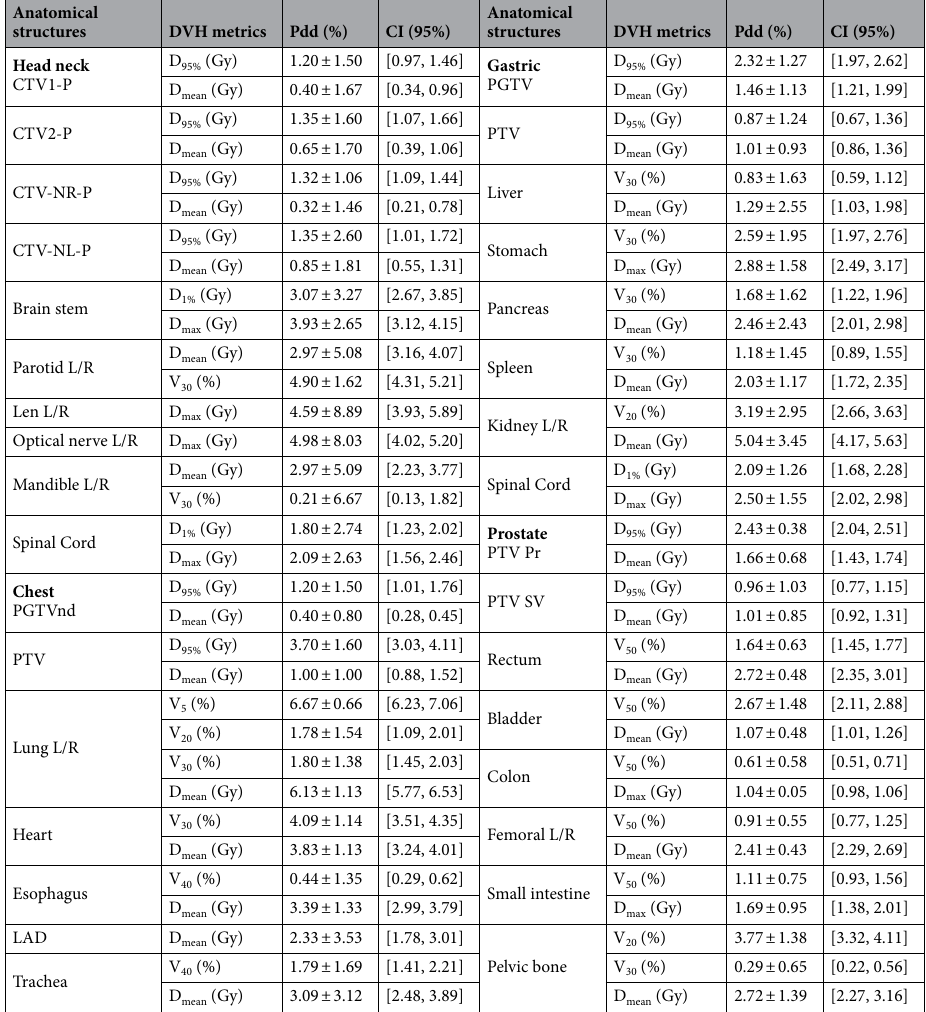
Table 2. Dosimetric differences in 43 VMAT plans at various anatomical sites (%, means ± SD). CTV1-P is the planning target volume of the high-risk clinical tumor area of the primary tumor; CTV2-P is the planning target volume of the low-risk clinical tumor area of the primary tumor; CTV-NR-P is the planning target volume of the clinical tumor area of the right lymph node; CTV-NL-P is the planning target volume of the clinical tumor area of the left lymph node. D 95% , D 1% = minimum dose received by 95% and 1% of the planning target volume, respectively; D mean = mean dose; V 5 , V 20 , V 30 , V 40 , V 50 = volume of the considered organ receiving 5 Gy, 20 Gy, 30 Gy, 40 Gy, and 50 Gy or less (in %). Pr = prostate; SV = seminal vesicles; PLN = pelvic lymph nodes; PTV is planning target volume; PGTV is planning gross tumor volume; PGTVnd is planning gross target volume (positive lymph node); Pdd/% = percent dose deviation; CI indicates confidence interval of Pdd/%